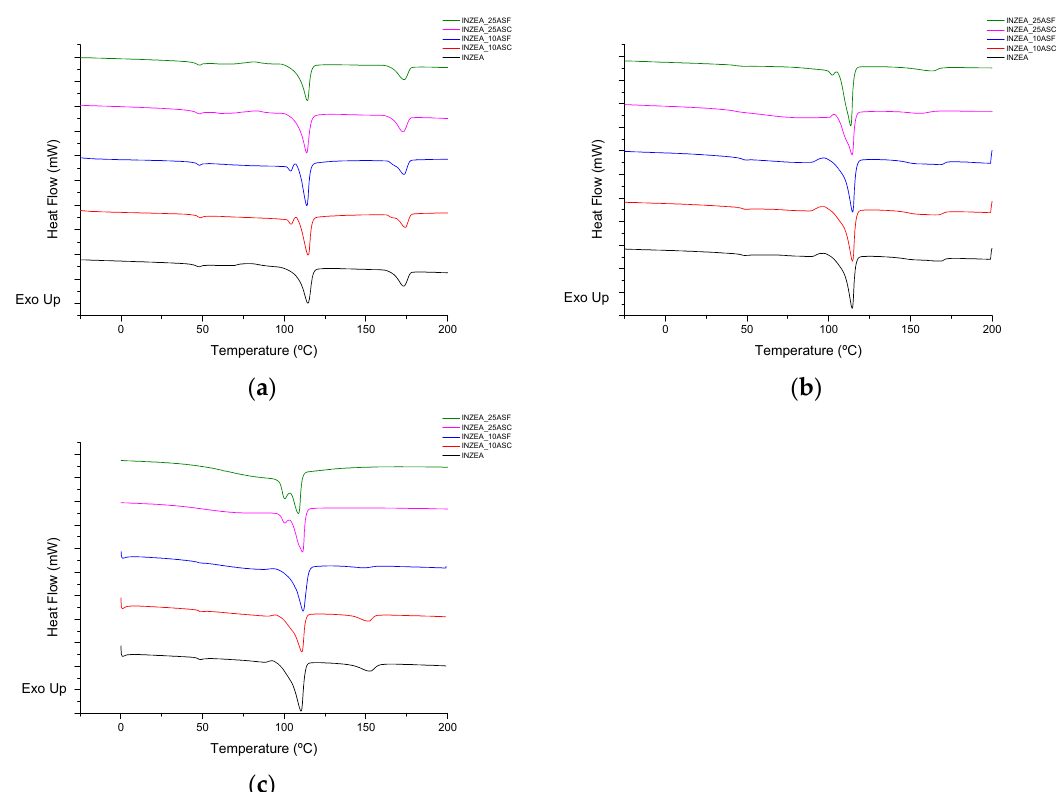
Figure 8. DSC thermograms of INZEA-based biocomposites with 10 and 25 wt % of ASP at two grinding levels (F, C) after different degradation times (( a ): 0 days, ( b ): 28 days, ( c ): 90 days) at 58 °C during the first heating scan (10 °C min -1 ).